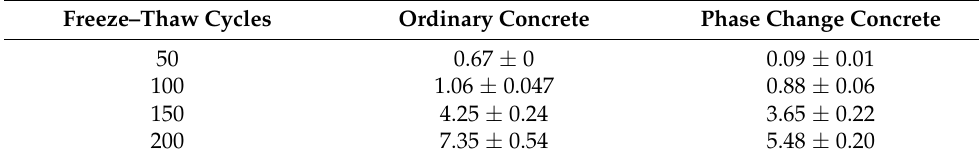
Table 10. Mass loss rate of concrete during freeze–thaw cycles (%).